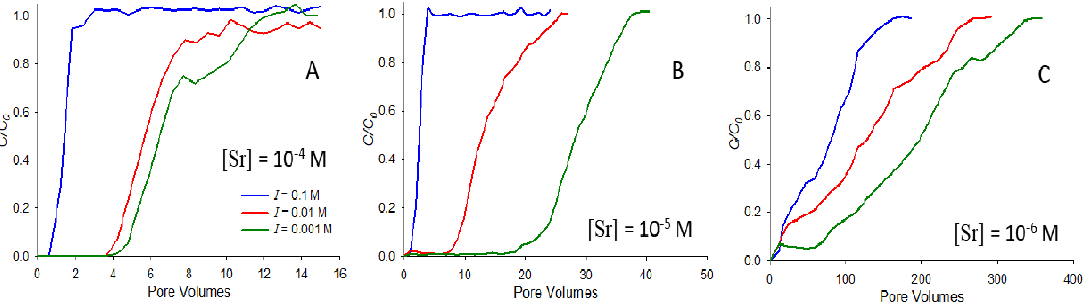
Figure 2. Breakthrough curves at pH 9 for Sr concentrations of 10 − 4 M ( A ), 10 − 5 M ( B ), and 10 − 6 M ( C ). Experiments conducted at ionic strengths of 0.1, 0.01, and 0.001 M NaNO 3 are shown.